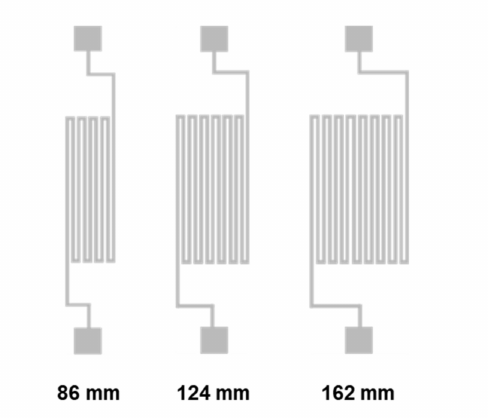
Figure 3. Design diagrams of 86, 124, and 162 mm-long